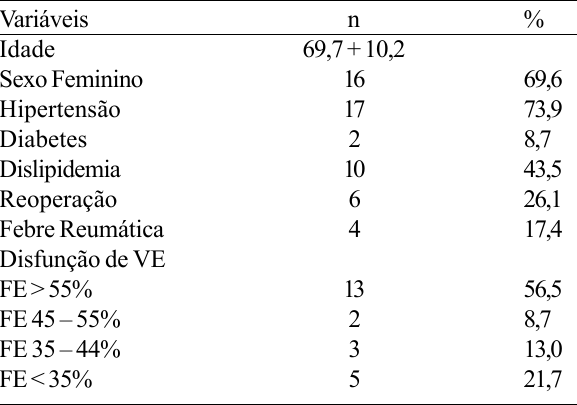
Tabela 1. Dados demográficos, fatores de risco e ecocardiográficos pré-operatórios.